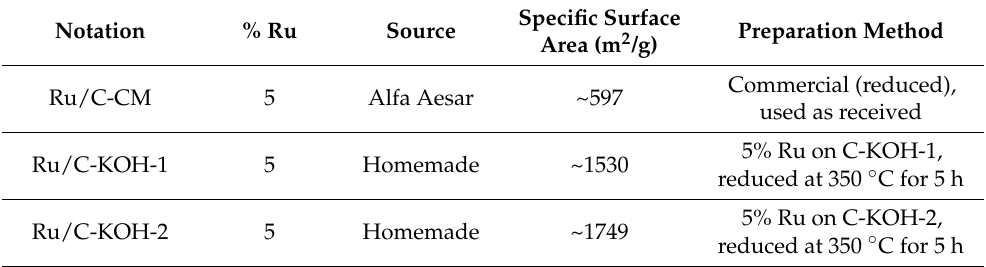
Table 1. The properties of investigated